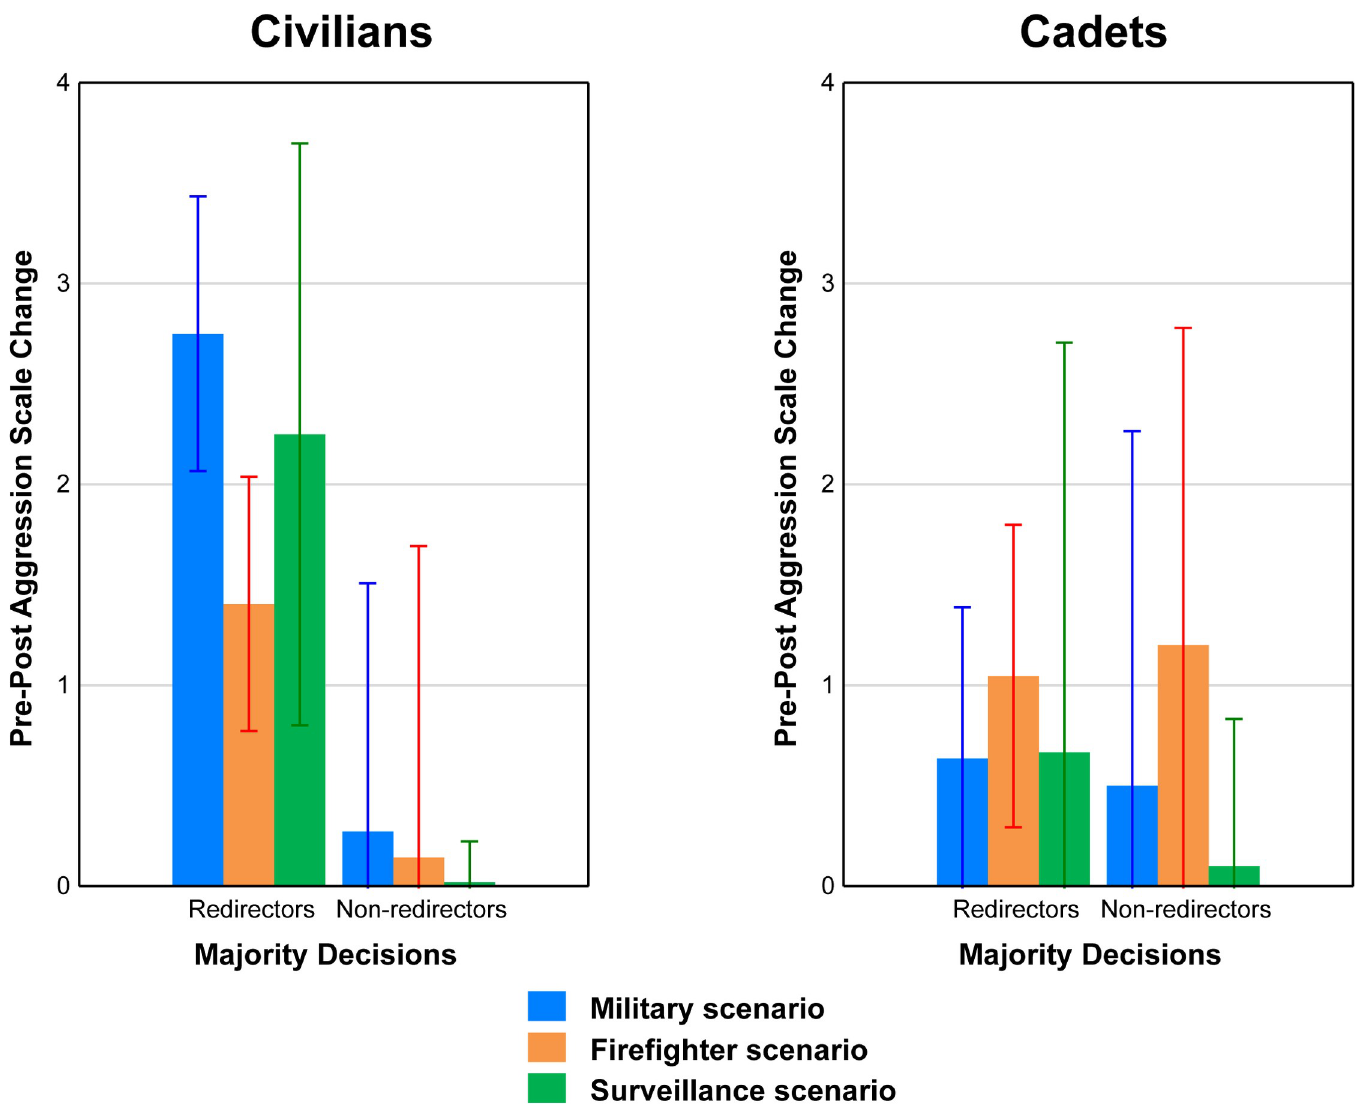
Fig 5. Aggression state measure. Pre-post difference in Aggression State score across all three Scenarios within each Mission for Civilians (left panel) and Cadets (right panel).